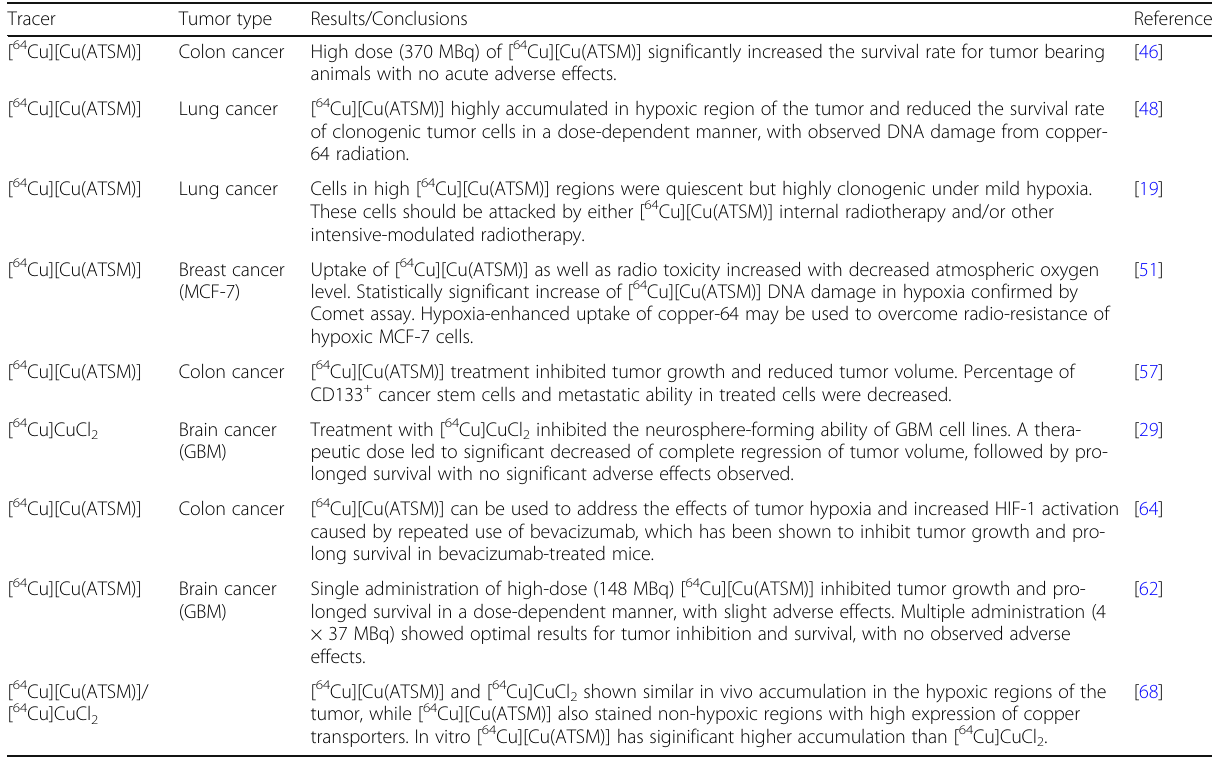
Table 2 Preclinical studies using copper-64 as therapeutic agent